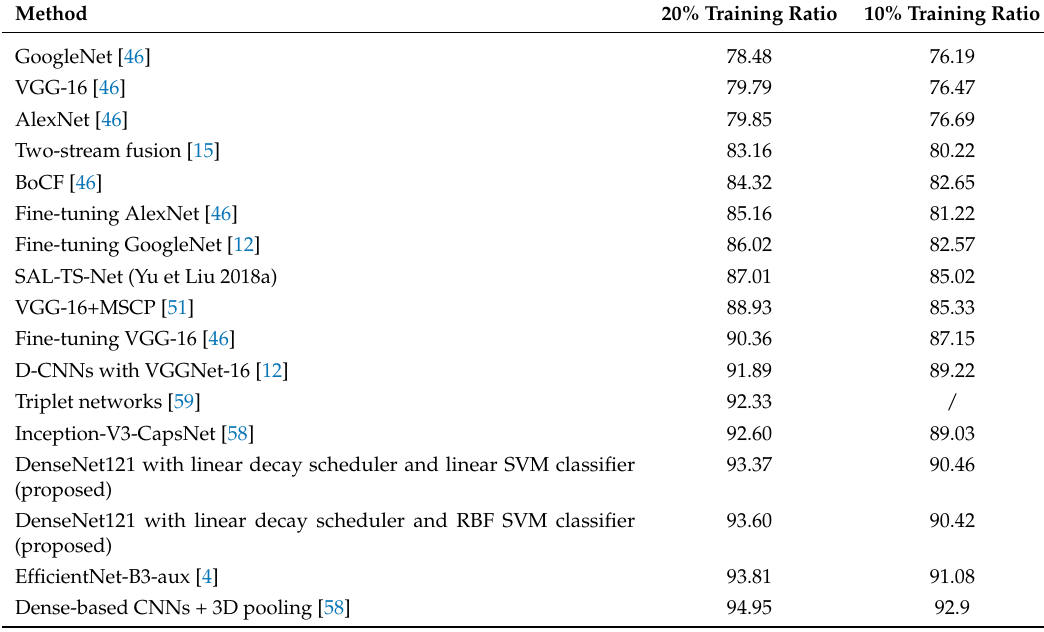
Table 6. Overall accuracy (%) of the proposed method compared to reference methods with 20% and 10% of NWPU-RESISC45 data set as a training set. For our method, we selected the best results obtained for the two training ratios, and report them in bold. Methods are ordered in ascending order by their performance on the 20% training